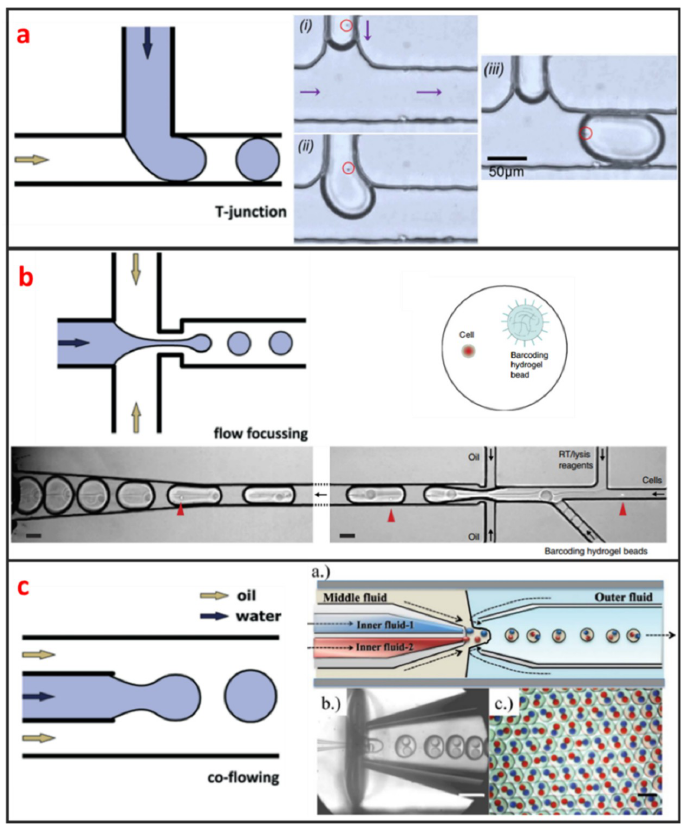
Figure 1. Three types of methods and designs for microfluidic single-cell droplet generation. Adapted